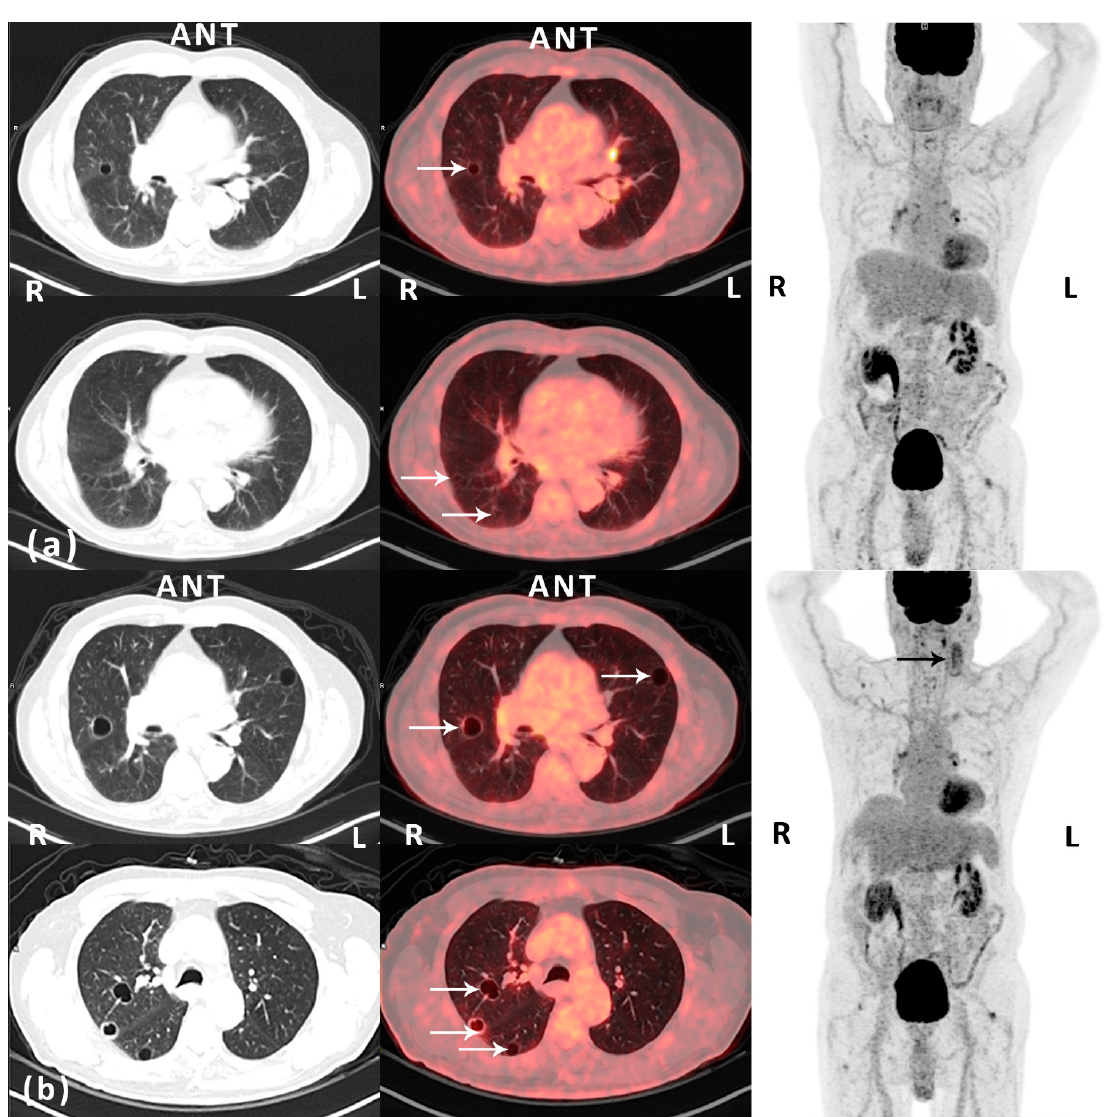
Figure 1. ( a ) Post ‐ operative (12 months after surgery) routine 18 F ‐ FDG PET/CT scan